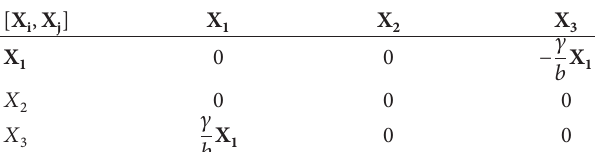
Table 3: Commutator table of the tumor